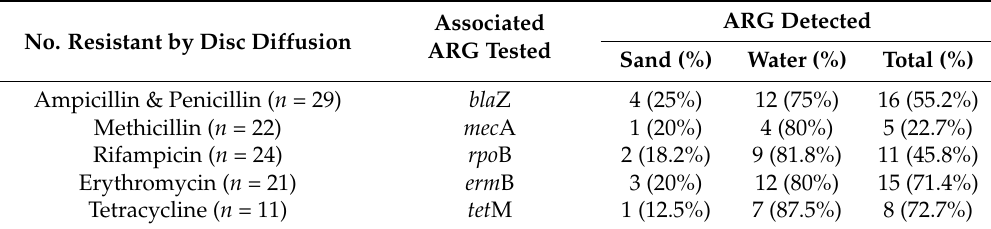
Figure 4. Representative gel showing PCR amplified products of fem A gene separated on 1.5% agarose. Lane 1: 100 bp DNA ladder (Fermentas Life Sciences, Vilnius, Lithuania), Lane 2: negative control, Lane 3–10: fem A (132 bp) positive isolate. Table 2. Antibiotic resistance genes detected in S. aureus isolates from beach sand and